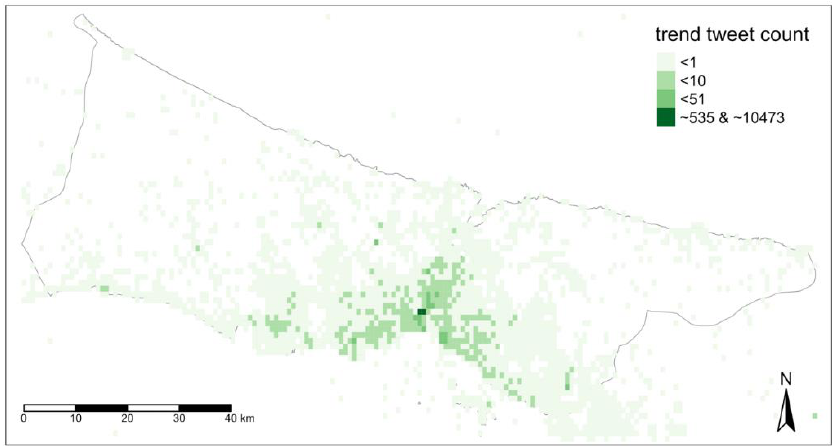
Figure 13. Average tweet count of trend values in each grid within 6 hours.